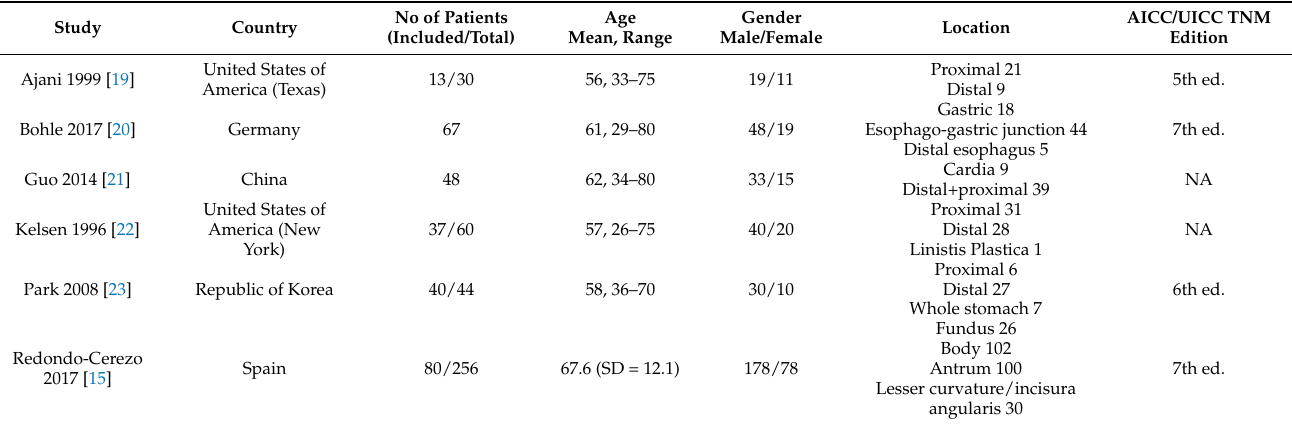
Table 1. The main characteristics of eligible studies in the